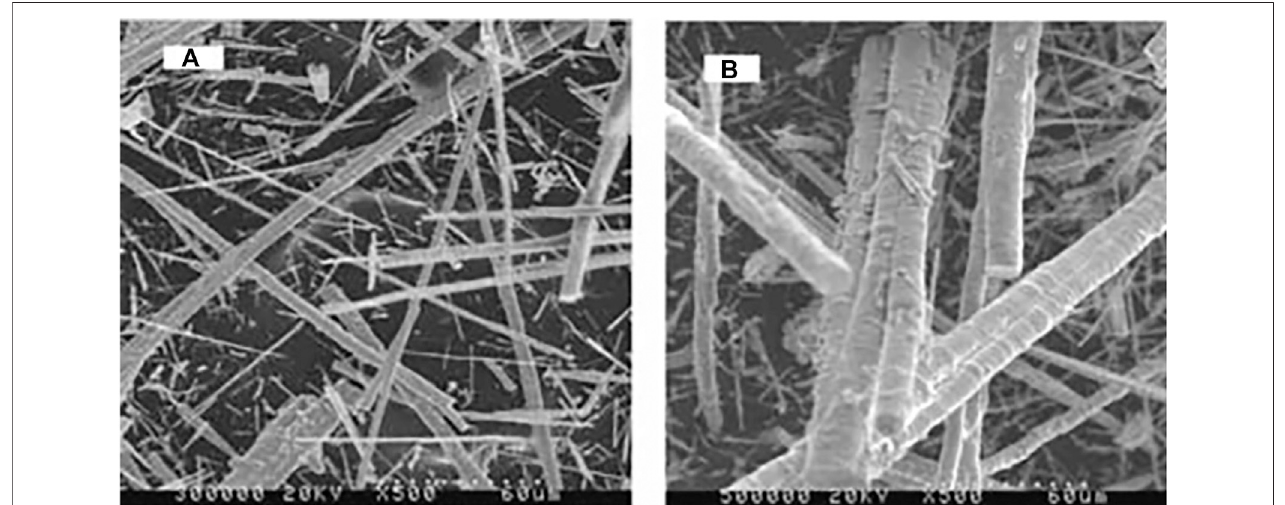
FIGURE 7 | SEM images of the original (A) and SiO 2 -coated (B) magnetic metal fi bers ( × 500).